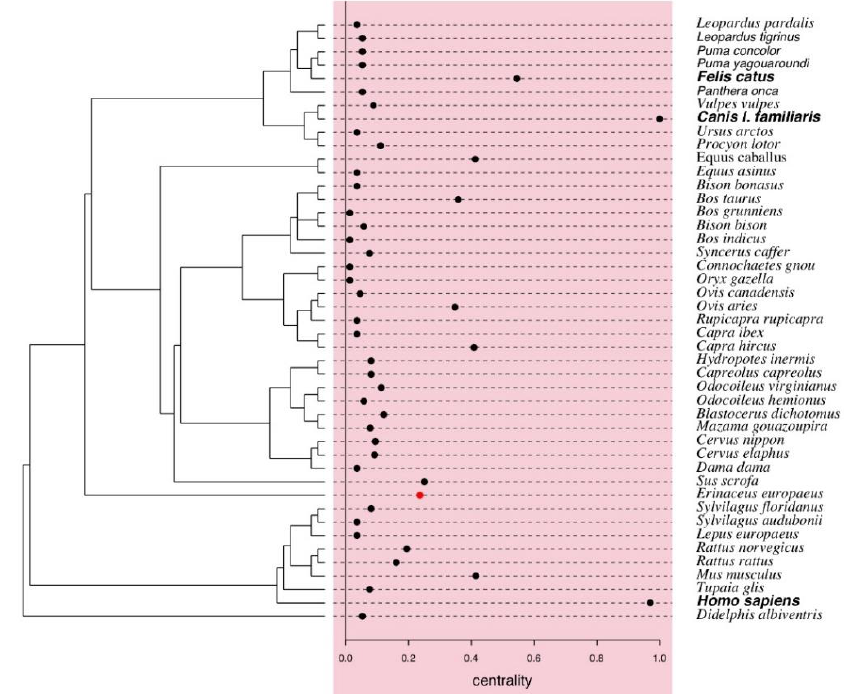
Figure 7. Centrality values of mammal carriers of rickettsial species extracted from unipartite network (Figure 4A), with phylogenetic tree obtained using ‘rotl’ [30] retrieved from the Tree of Life [31]. A significant phylogenetic signal for the centrality value of the European hedgehog was detected (red dot).